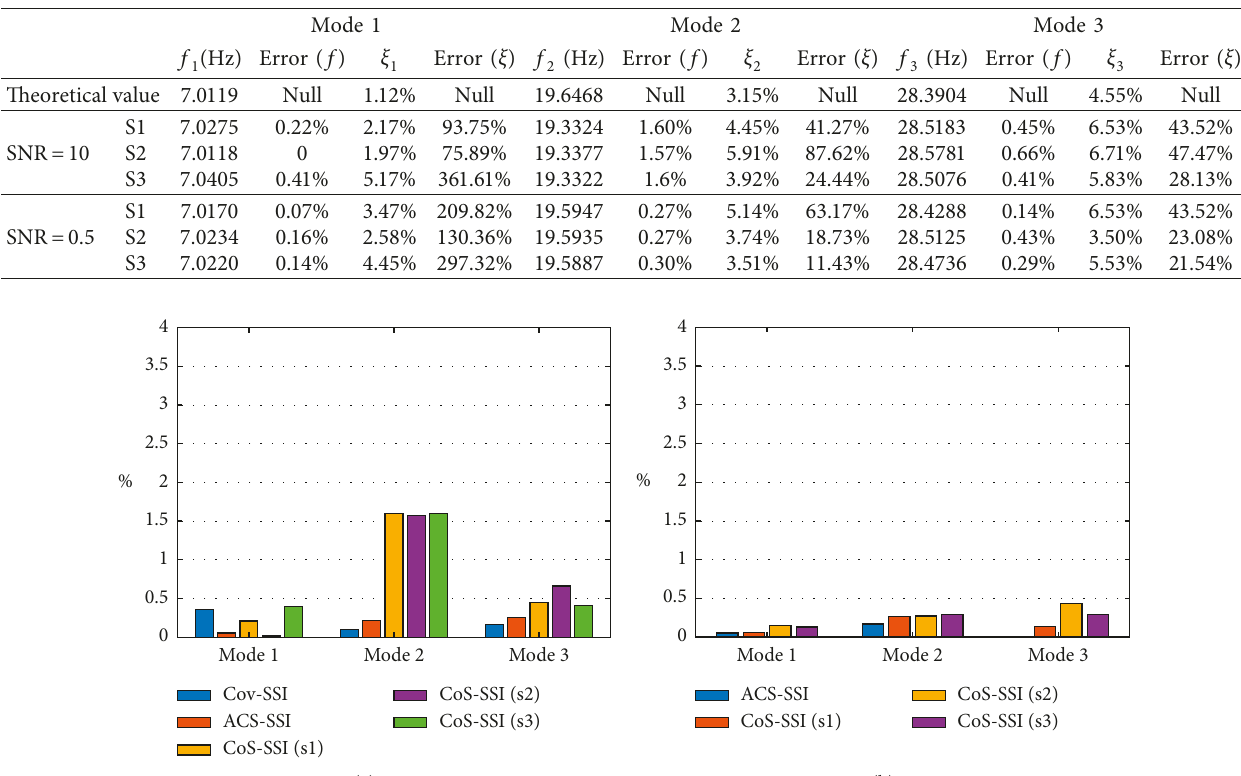
Table 4: CoS-SSI results.